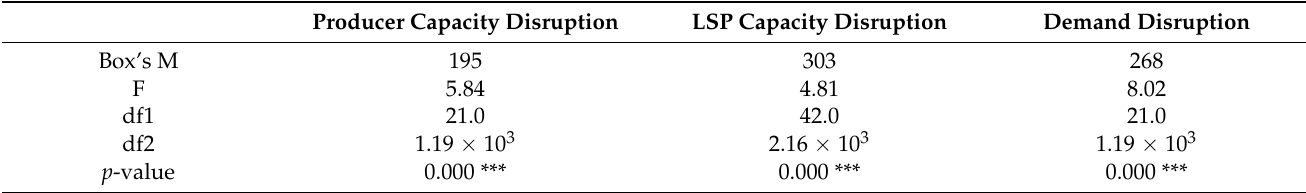
Table 3. Box’s test of equality of covariance